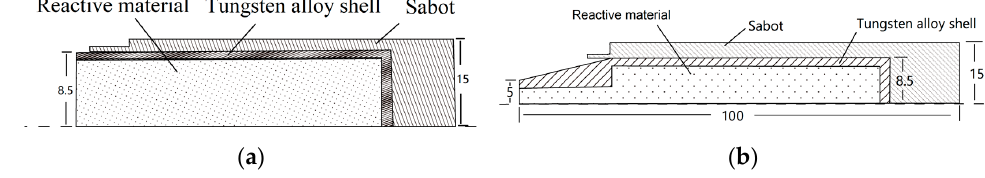
Figure 1. Schematic diagram of PELE projectile. ( a ) Conventional PELE projectile. ( b ) Newly designed PELE projectile.